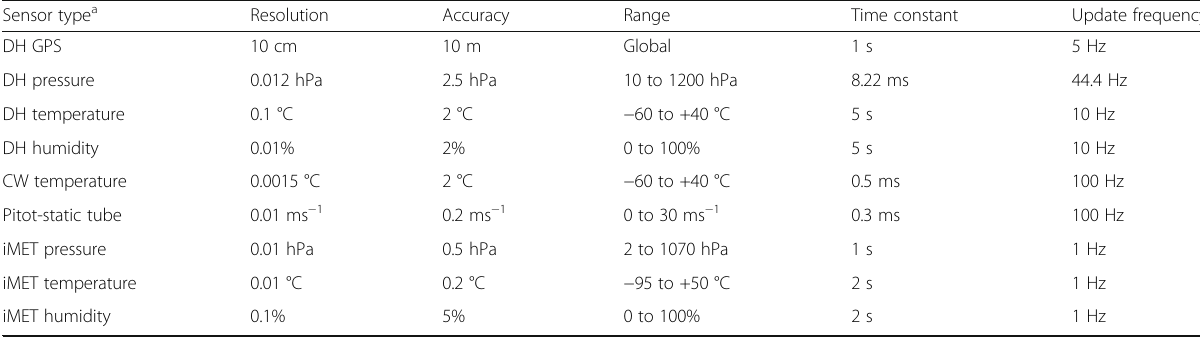
Table 2 List of sensors on board DataHawk UAV Sensor type